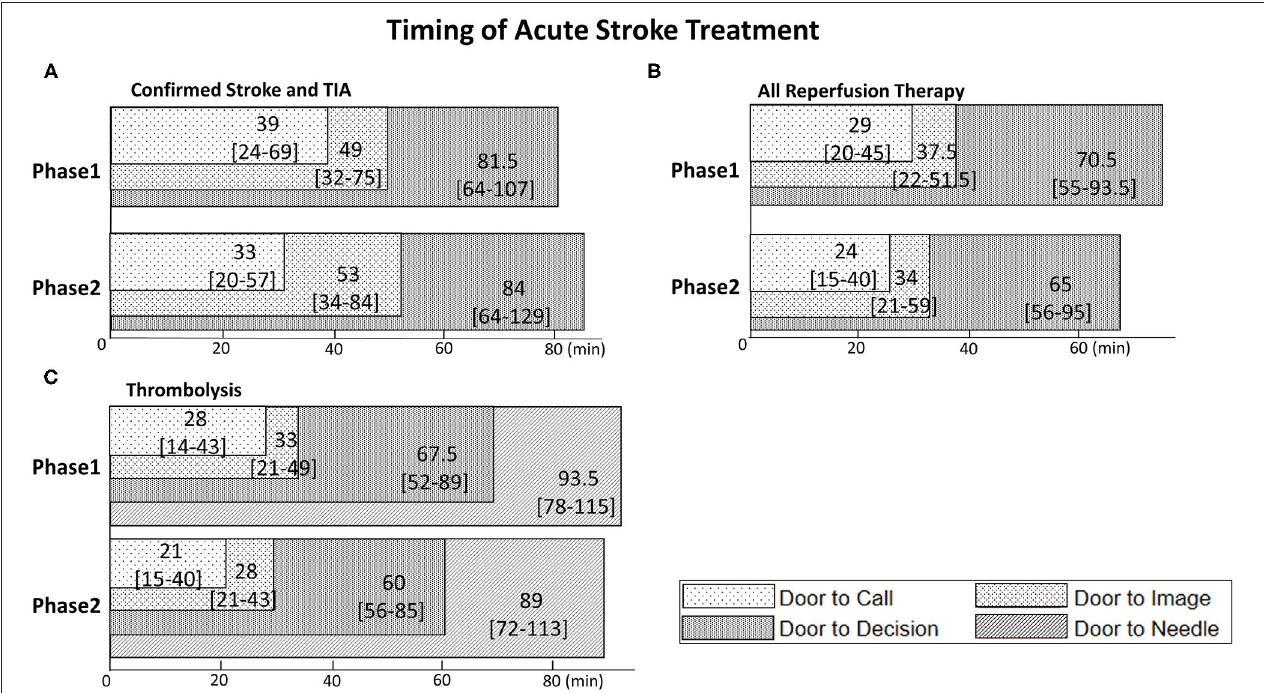
FIGURE 2 | Superimposed bar graphs of Door-to-Call, Door-to-Image, Door-to-Decision, and Door-to-Needle time. Numbers in each bar are median time and [IQR] (min). (A) Confirmed ischemic stroke patients and TIA patients in phase 1 and 2. (B) Patients who underwent reperfusion therapy. (C) Patients who underwent thrombolysis.